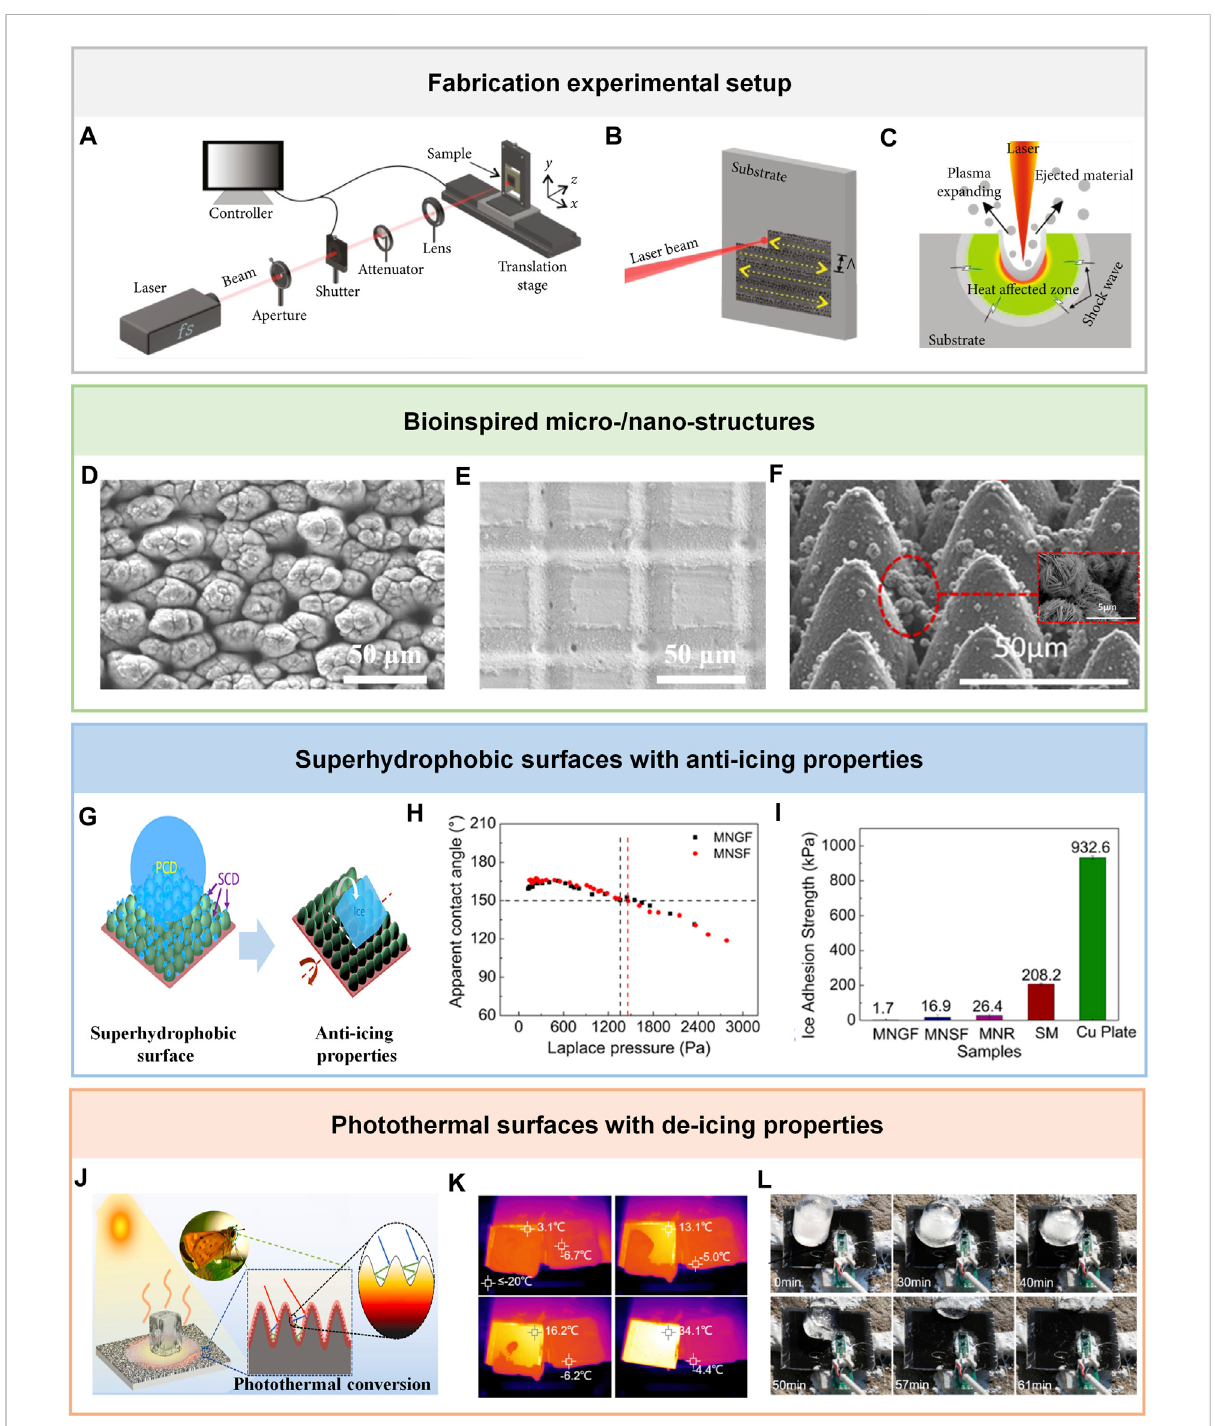
FIGURE 1 Fabrication of anti-icing/de-icing surfaces using the femtosecond laser. (A) Femtosecond laser direct writing experimental setup. (B) The schemeforlaserscanning. (C) Theschemefortheinteractionbetweenfemtosecondlaserandmaterials.ReproducedunderthetermsoftheCC-BY CreativeCommonsAttribution4.0InternationalLicense(Yongetal.,2022a)Copyright2022,TheAuthors,PublishedbyAAAS.Reproducedunderthe